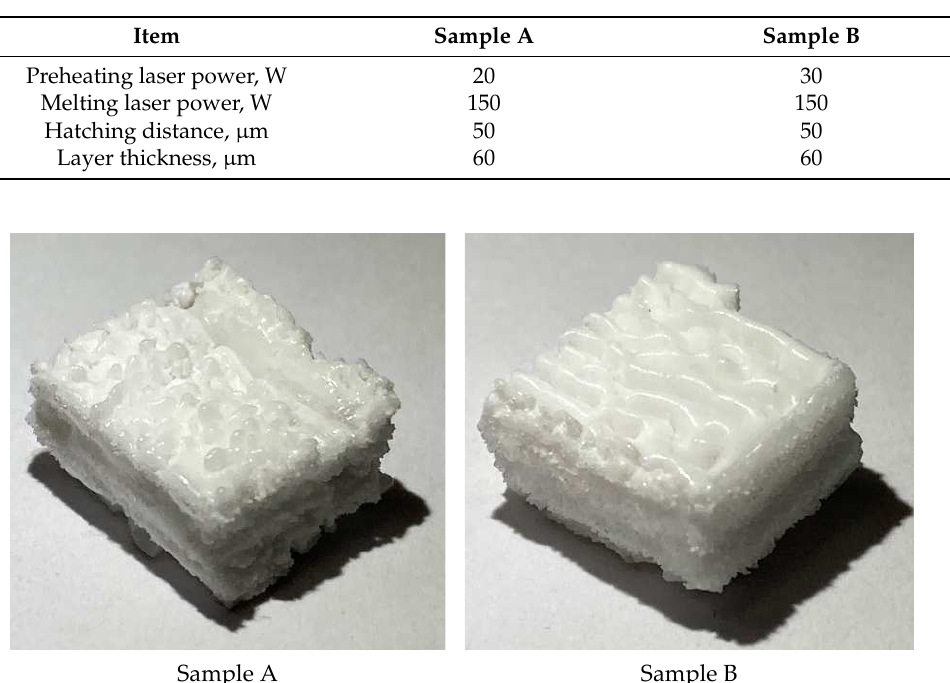
Figure 13. Relative density of alumina samples printed using the developed preheating system: with 20 W preheating laser power (Sample A) and 30 W (Sample B) Figure 14 shows the SEM images for the top surface of alumina samples (without polishing). The samples experienced a level of porosity which may result from the large powder size distribution used as a feedstock. No cracks were detected on sample A, and the traces were well connected. The absence of cracks was mainly due to the low-temper- ature gradient developed on the powder bed due to preheating. Sample B experienced a transverse crack pattern and high porosity level. This is mainly due to the high preheating laser power used for the sample that resulted in its low relative density.